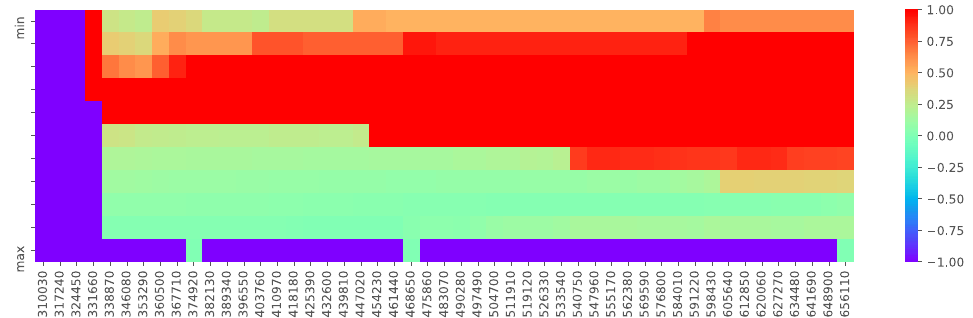
Figure 8. The Allocation Results of usr_1.